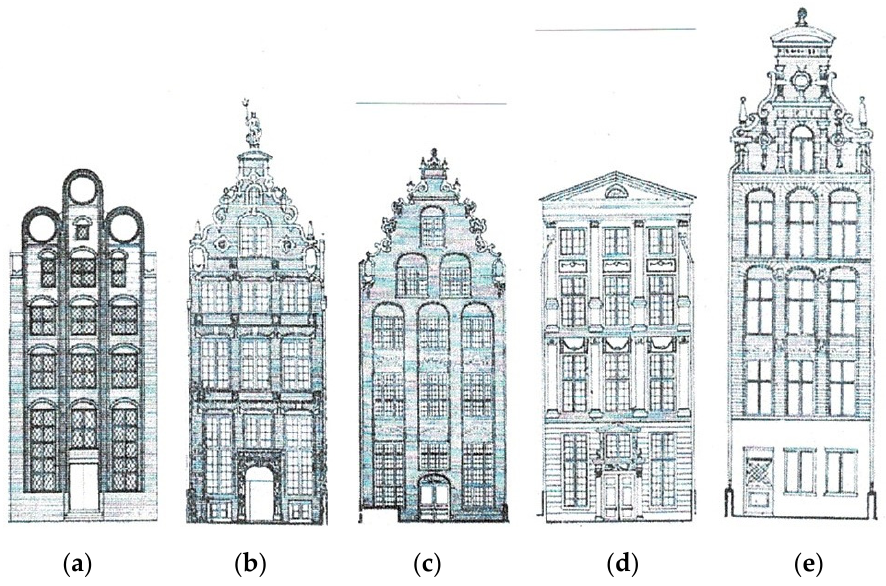
Figure 3. Elevations of Gda ń sk tenement houses: ( a ) Gothic, ( b ) Renaissance, ( c ) Baroque, ( d ) Classicist, ( e ) Eclectic [46].